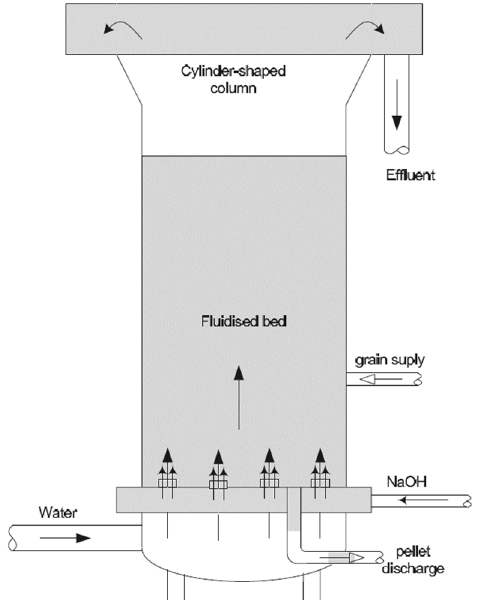
Figure 6. Structure of a fluidized bed reactor [35].